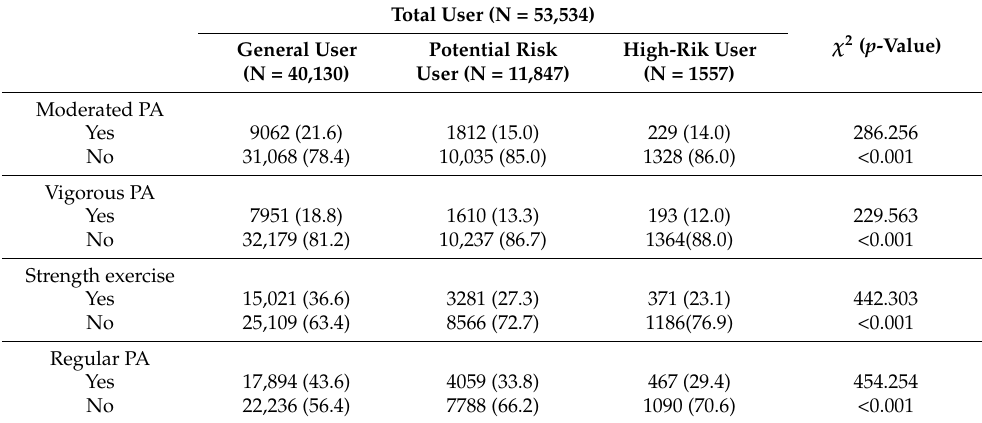
Table 2. Difference in physical activity based on level of smartphone